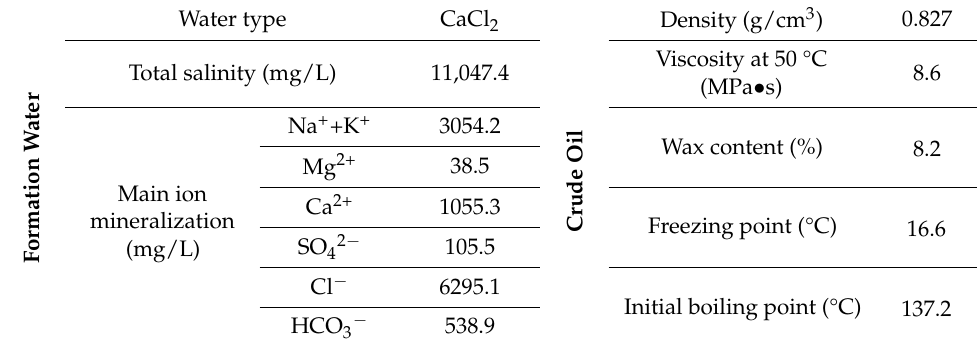
Table 1. Experimental material